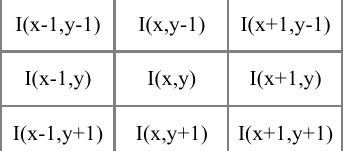
Figure 3. Pixel noise filter neighborhood.